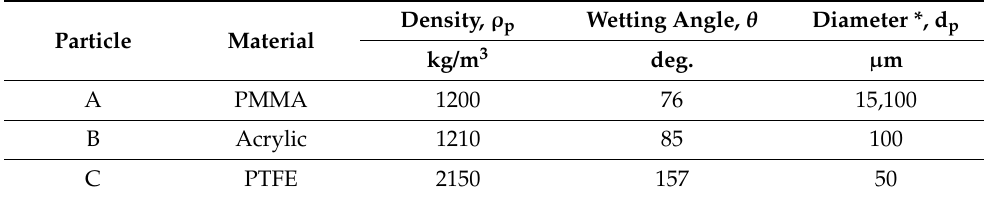
Table 1. Properties of particles used in the experiments.